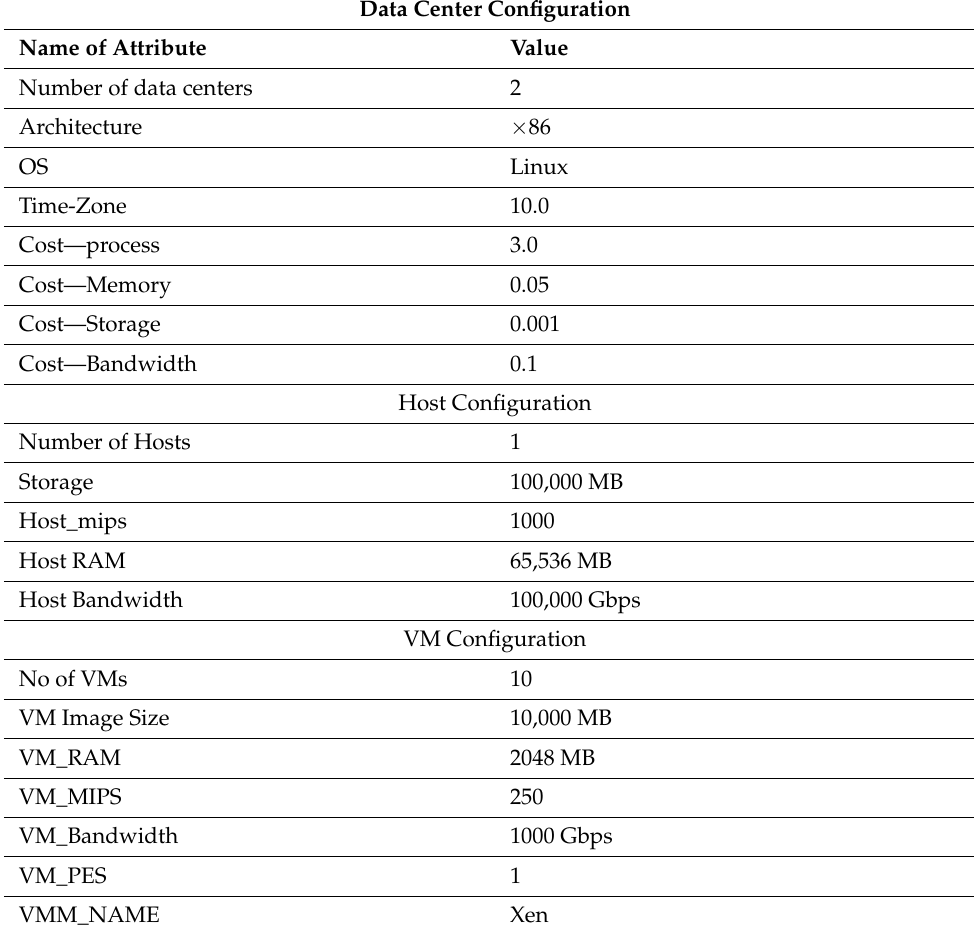
Table 1. Initial CloudSim